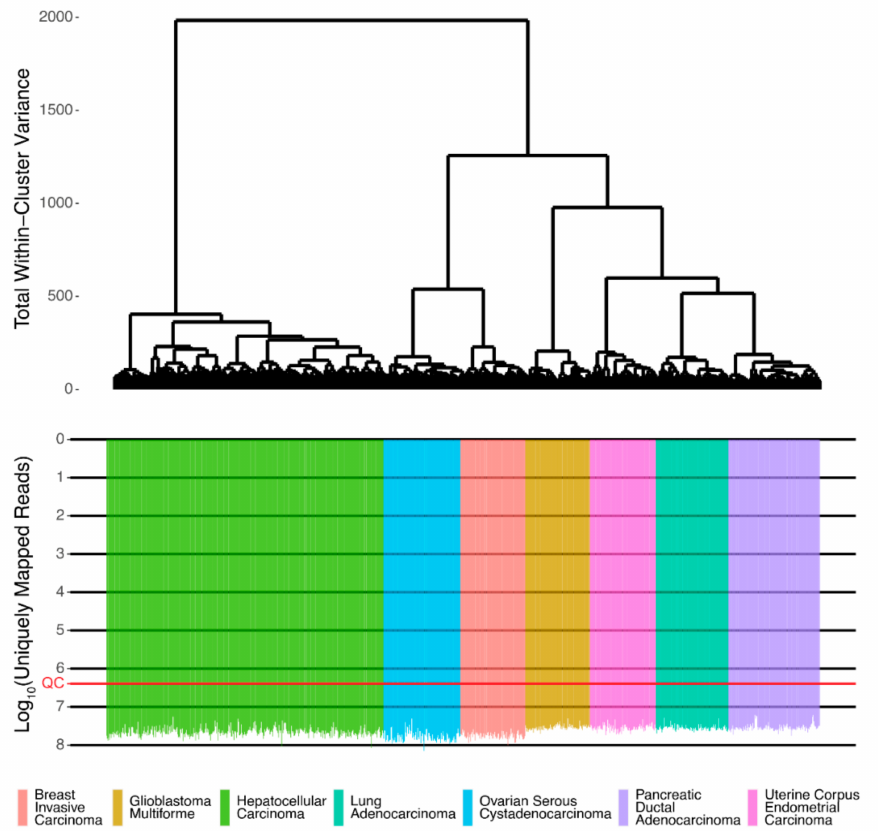
Figure 1. The dendrogram of hierarchical clustering for QC-passed RNA sequencing profiles of human tissues from TCGA. Gene expression data were used to calculate Euclidian distances between the samples. The color markers indicate the tissue types. The lower scale indicates the number of uniquely mapped reads. ‘QC’ marker denotes the quality control threshold of 2.5 million uniquely mapped